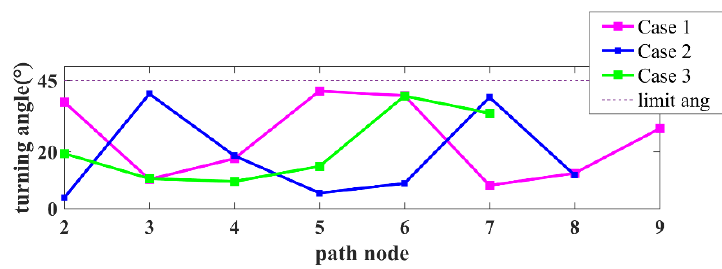
ISPRS Int. J. Geo-Inf. 2021 , 10 , x FOR PEER REVIEW